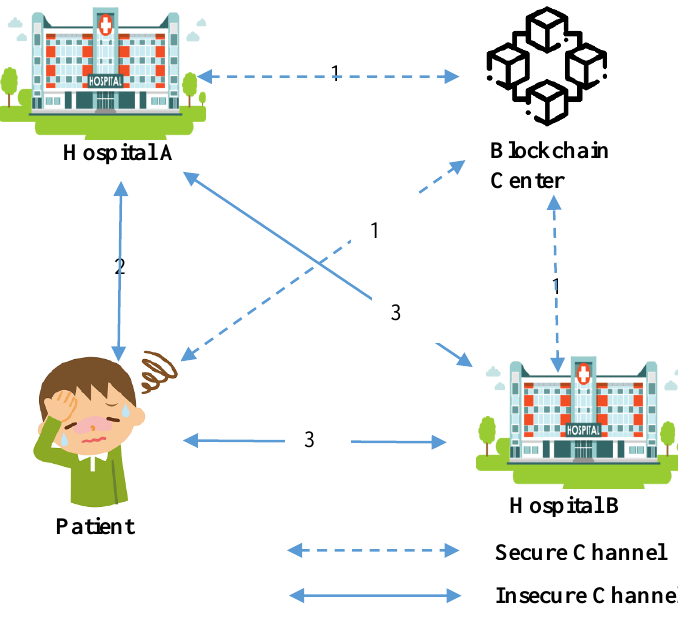
Figure 1. The framework of the blockchain-based secure inter-hospital EMR sharing